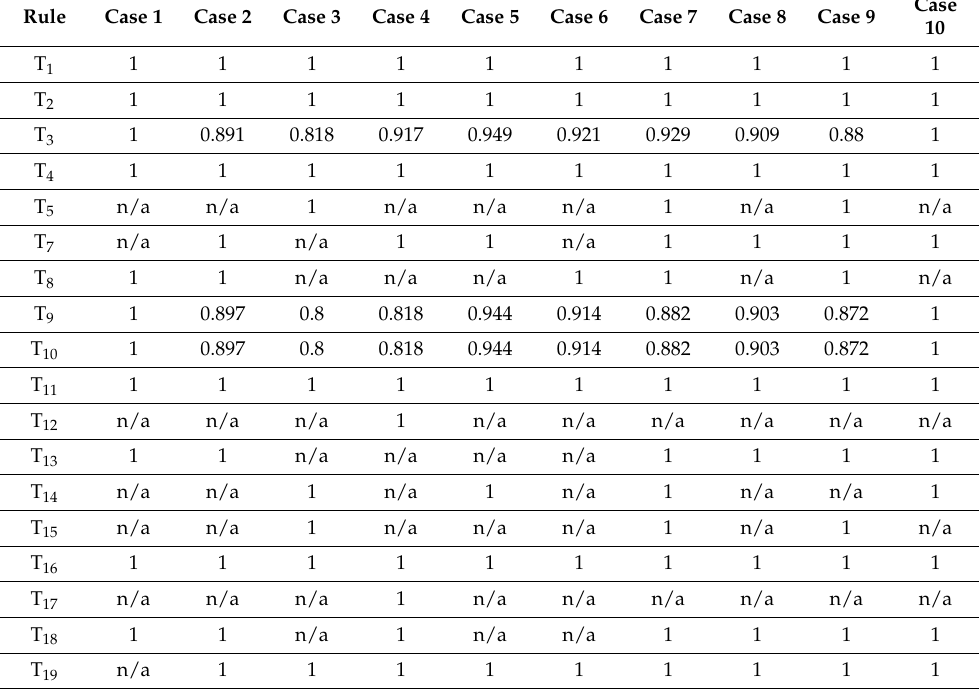
Table 2. Transformation execution